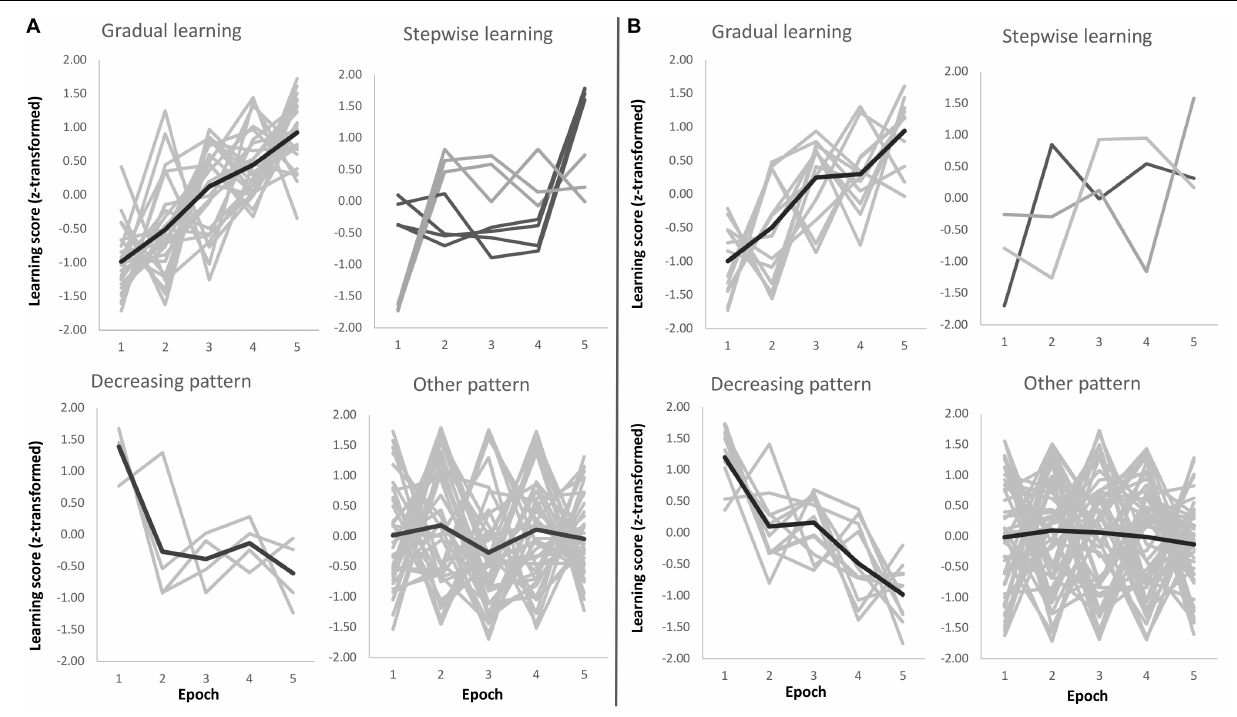
η 2 = 0.02), nor the interactions GROUP × EPOCH ( F 4 , 150 = 0.52, p = 0.01), GROUP × LEARNING TYPE ( F 2 , 75 = p = 0.67, η 2 p